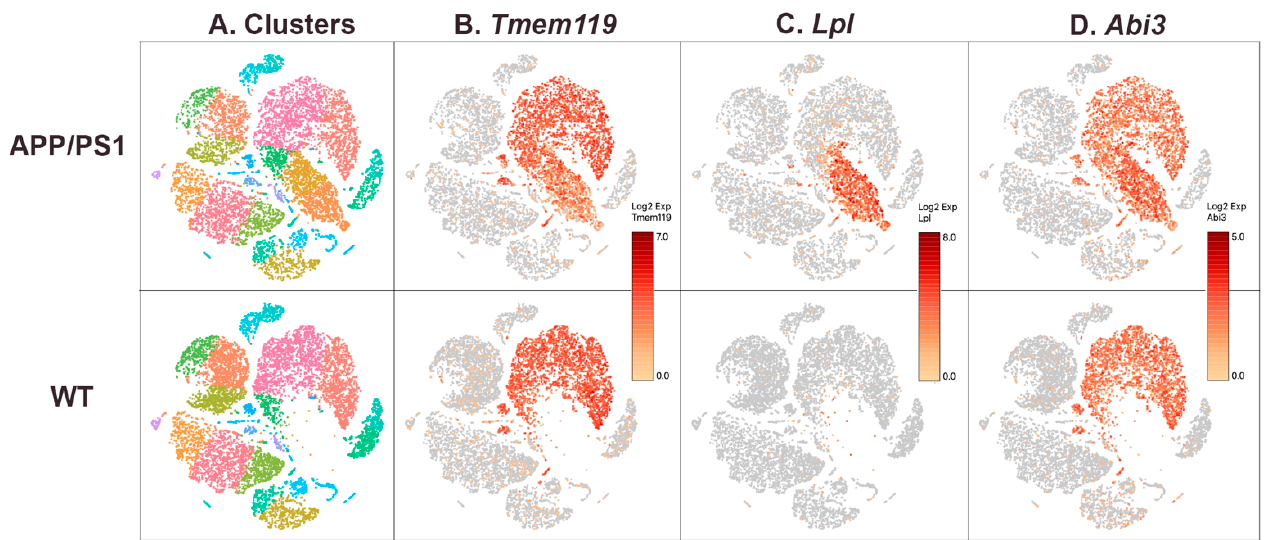
Figure 5. ABI3 expression is largely restricted to microglia, including apparent disease-associated microglia. Individual cells were clustered based on Loupe Browser analysis of transcript profiles and are color-coded to show these groups ( A ). Microglia were identified by virtue of Tmem119 expression ( B ). Disease-associated microglia were identified by using Lpl expression ( C ). Note that this subpopulation of microglia is present in the APP/PS1 but not WT mice ( C ). Abi3 was expressed in the same cell populations as Tmem119 , including the disease-associated microglial population ( D ).